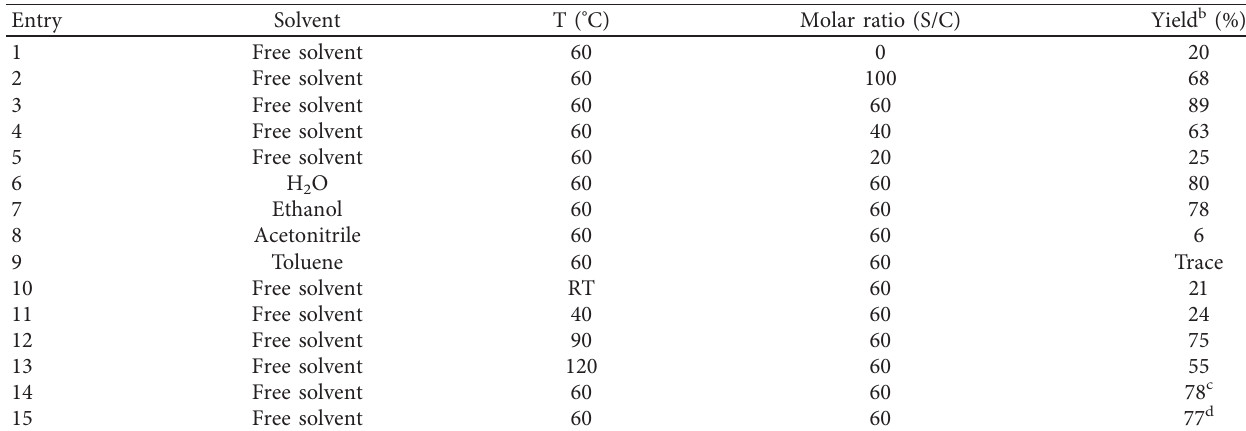
Scheme 2: The standard reaction for optimization. Table 2: Optimization of the standard reaction a